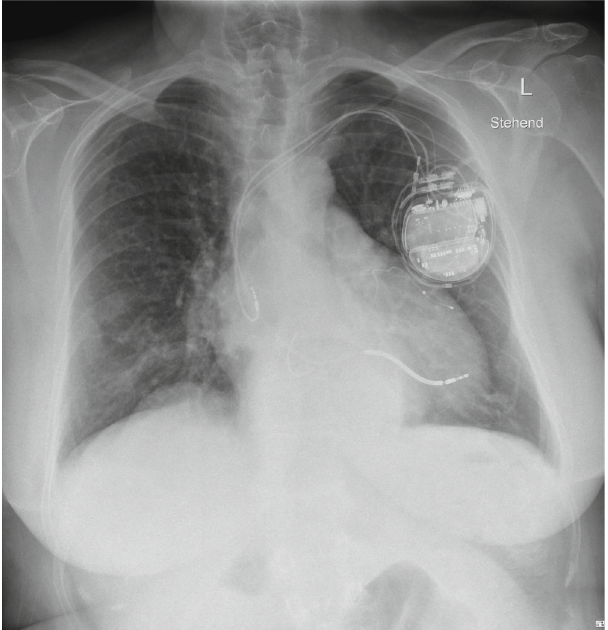
Figure 2: Post-implantation chest X-ray in posterior – anterior view. Figure 3: Chest X-ray in lateral